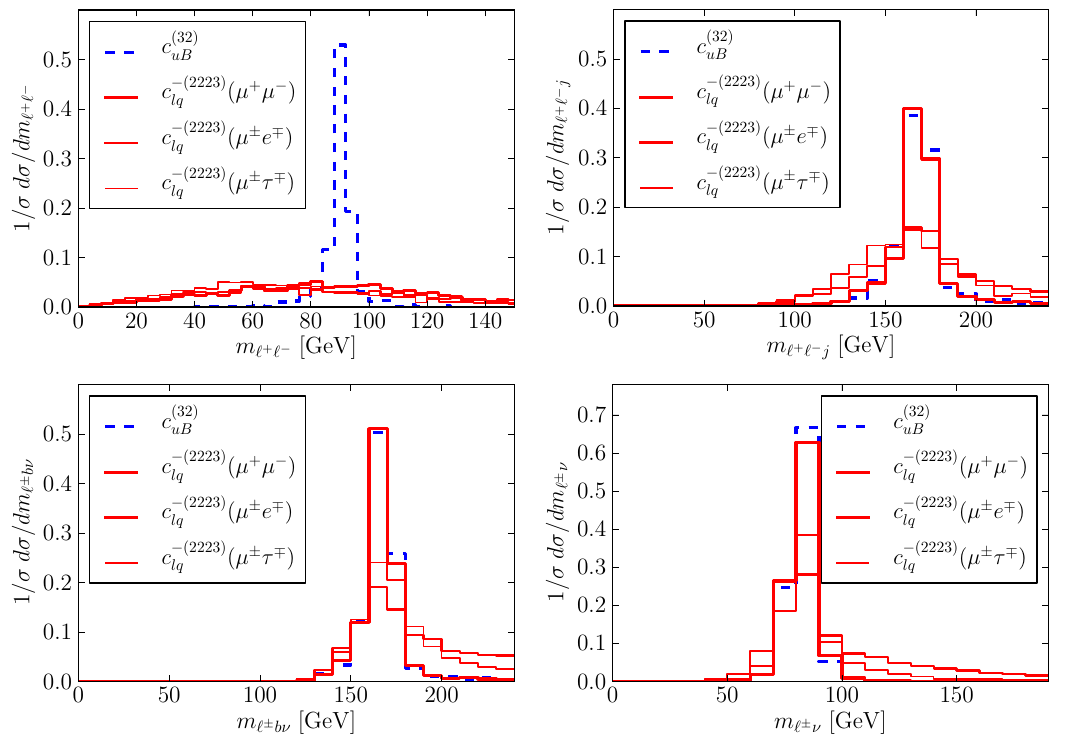
Figure 3 . Top left: normalized distribution of m ‘ + ‘ (cid:0) in the three lepton (cid:12)nal state of top pair events with one top decaying as t Zj (dashed blue), and in the case in which the latter decays ! as t j‘ (cid:6) ‘ (cid:7) (solid red) for di(cid:11)erent LFV combinations. Top right: same before but for m ‘ + ‘ (cid:0) j . i j ! Bottom left: same as before but for m ‘ (cid:6) b(cid:23) . Bottom right: same as before but for m ‘ (cid:6) (cid:23)